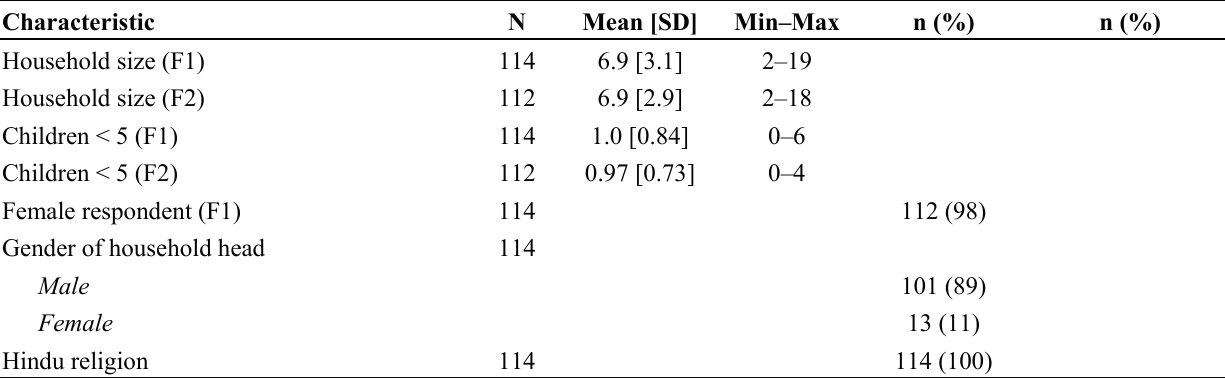
Table 2. Pilot study household descriptive